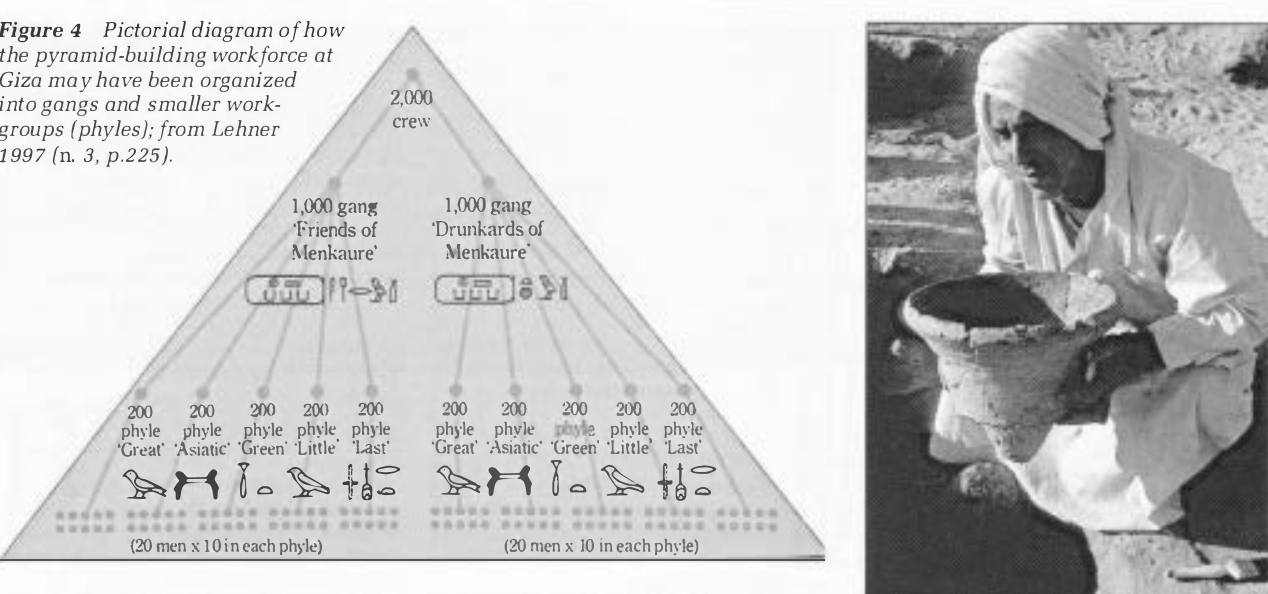
Figure 4 Pictorial diagram of how the pyramid-building workforce at Giza may have been organized into gangs and smaller work­ groups (phyles}; from Lehner